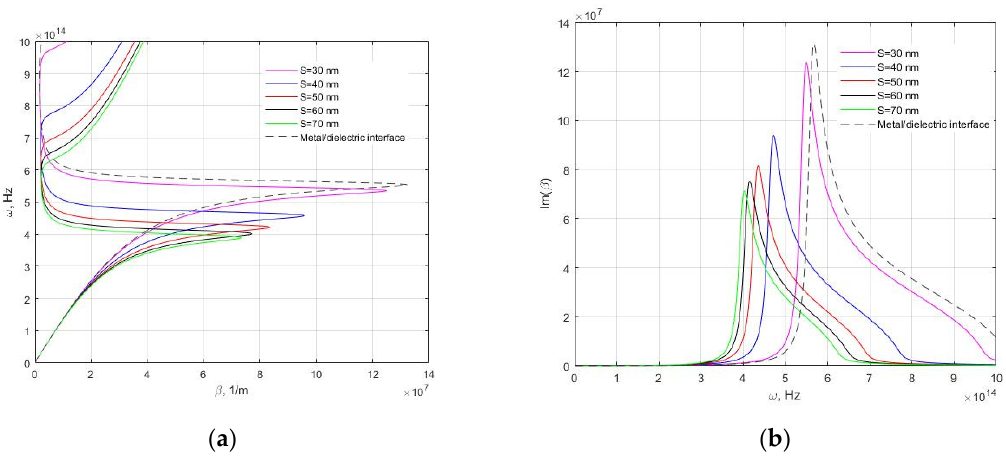
Figure 5. Mode patterns of the surface waves at the interface of metamaterial and dielectric ( ε d = 11.8). d = 30 nm. Dependencies of the real ( a ) and imaginary ( b ) parts of the propagation constant, upon frequency.